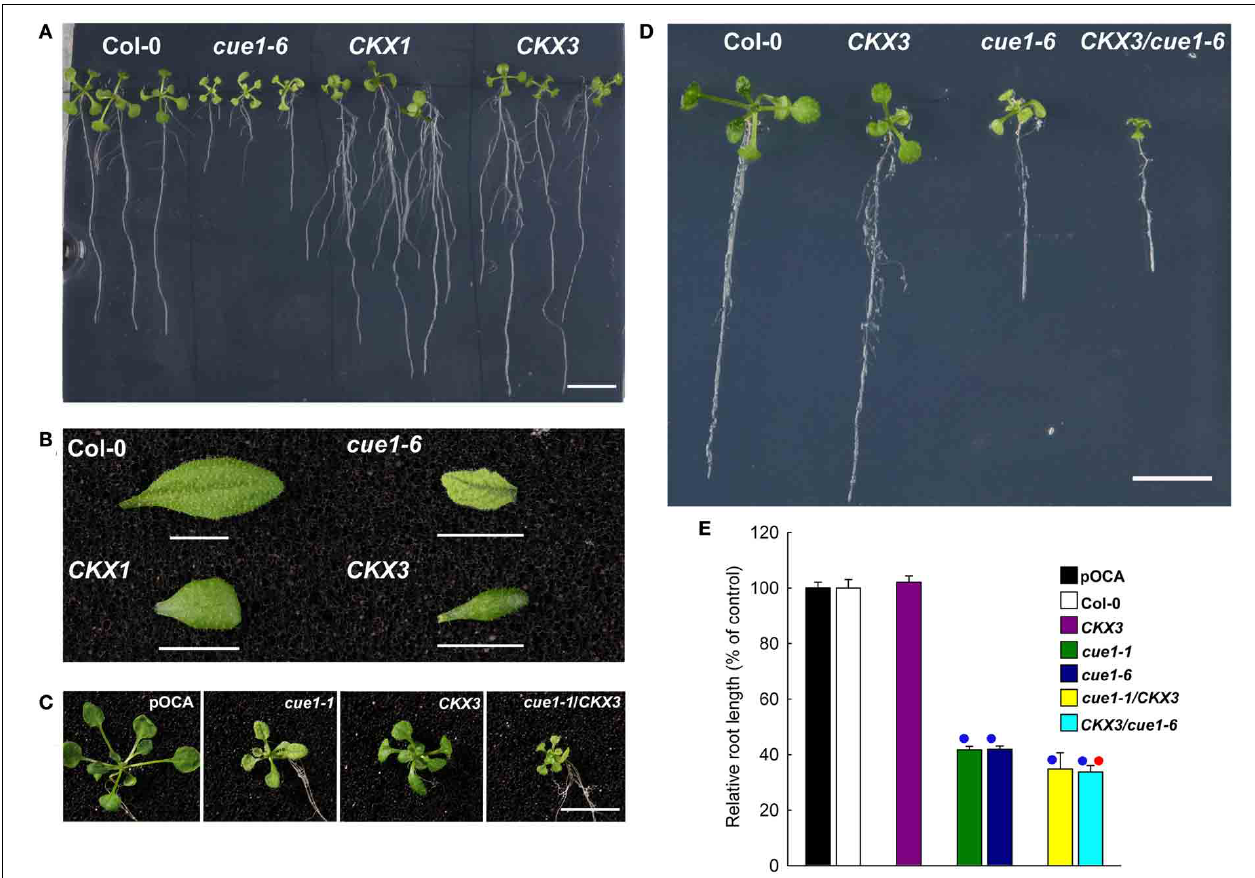
FIGURE 11 | Root lengths of cue1 mutants compared to the wild type/control and CKX overexpressing lines. Root (A) and leaf phenotypes (B) of Col-0, cue1-6 and CKX1 and CKX3 overexpressing lines as well as root (C) and leaf phenotypes (D) of stable crosses of cue1-6 with CKX3 (C) or CKX3 with cue1-1 (D) were assessed three